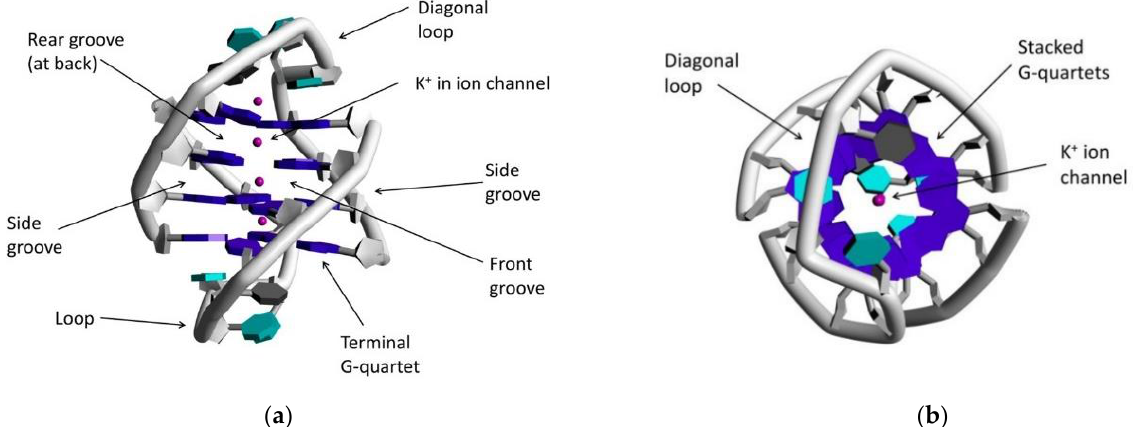
Figure 6. ( a ) Representation of G-quadruplex system with highlighted and labeled parts (PDB code 1JPQ); ( b ) view of the same quadruplex from different angle. Adapted with permission from Ref. [102]. Copyright (2016) American Chemical Society.